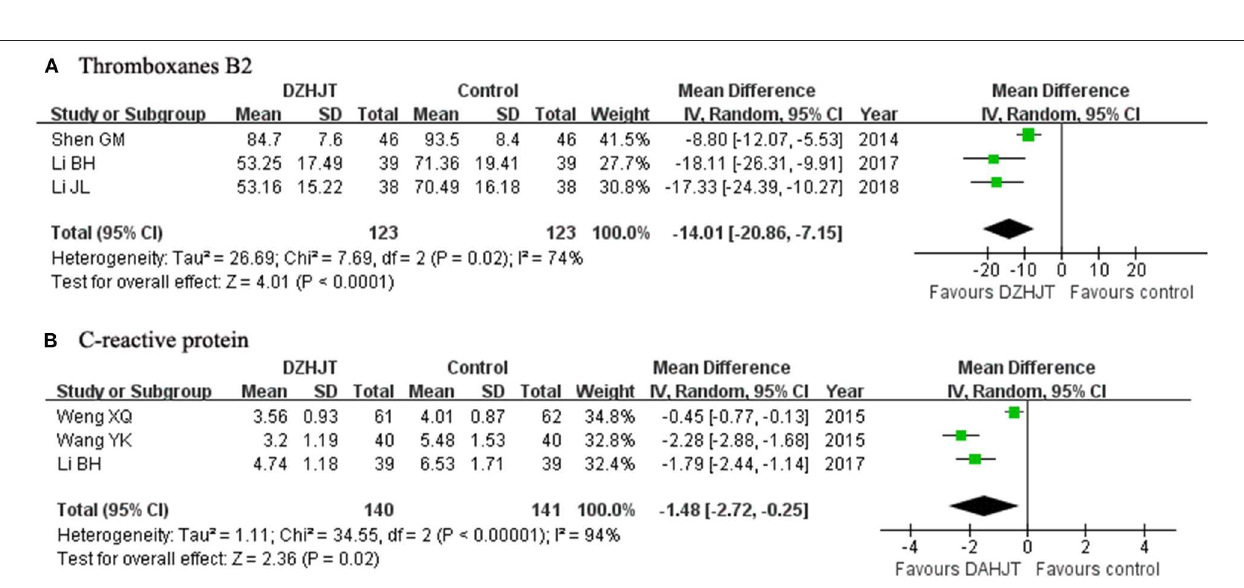
Frontiers in Pharmacology |